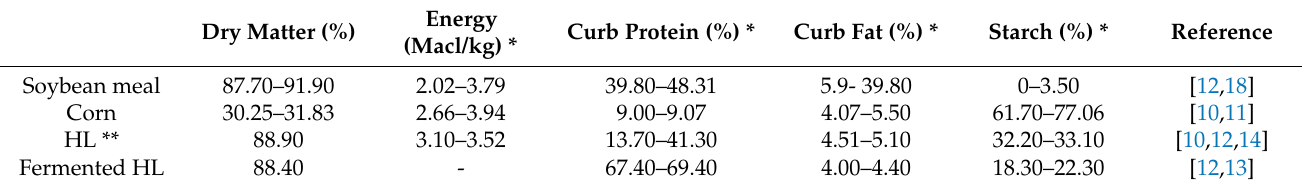
Table 2. Component concentration in different